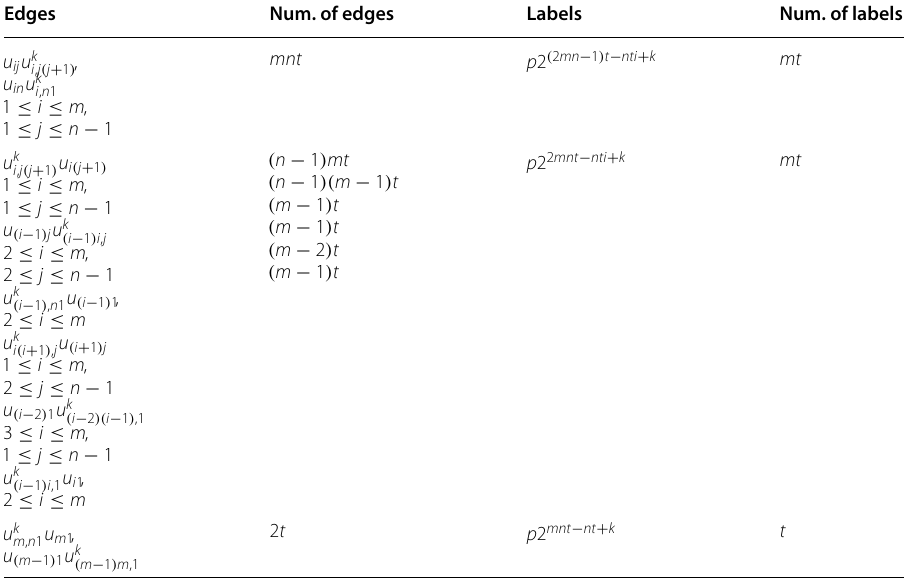
Table 2 Zumkeller numbers used to label the edges of SSD ( C m × P n ) Edges Num. of edges Labels Num. of